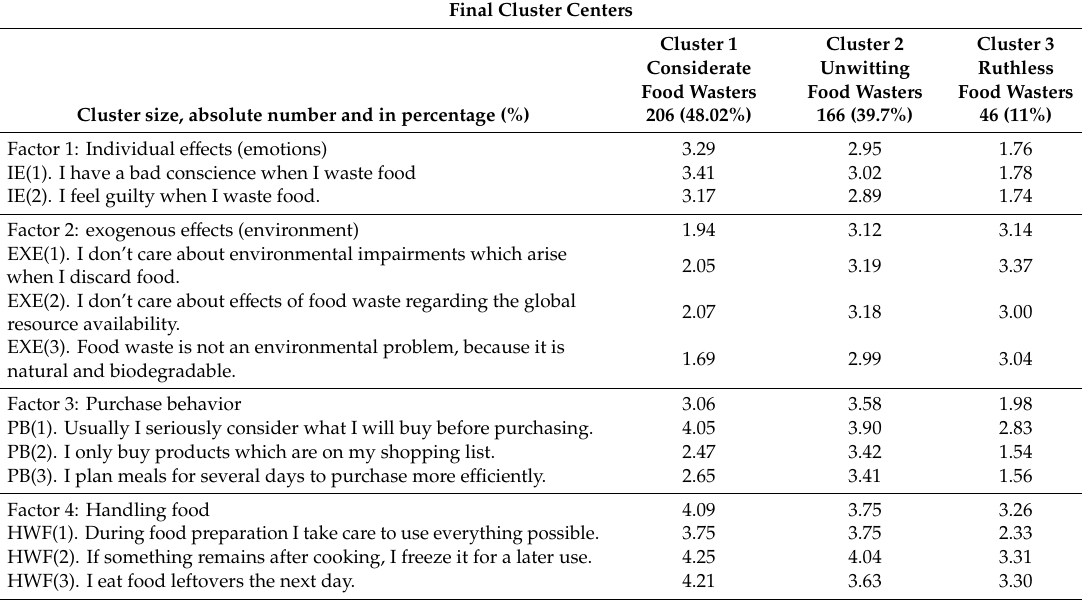
Figure 2. Analysis of the distances between the coe ffi cients from the agglomeration schedule. Table 4. Result of the cluster analysis—cluster forming